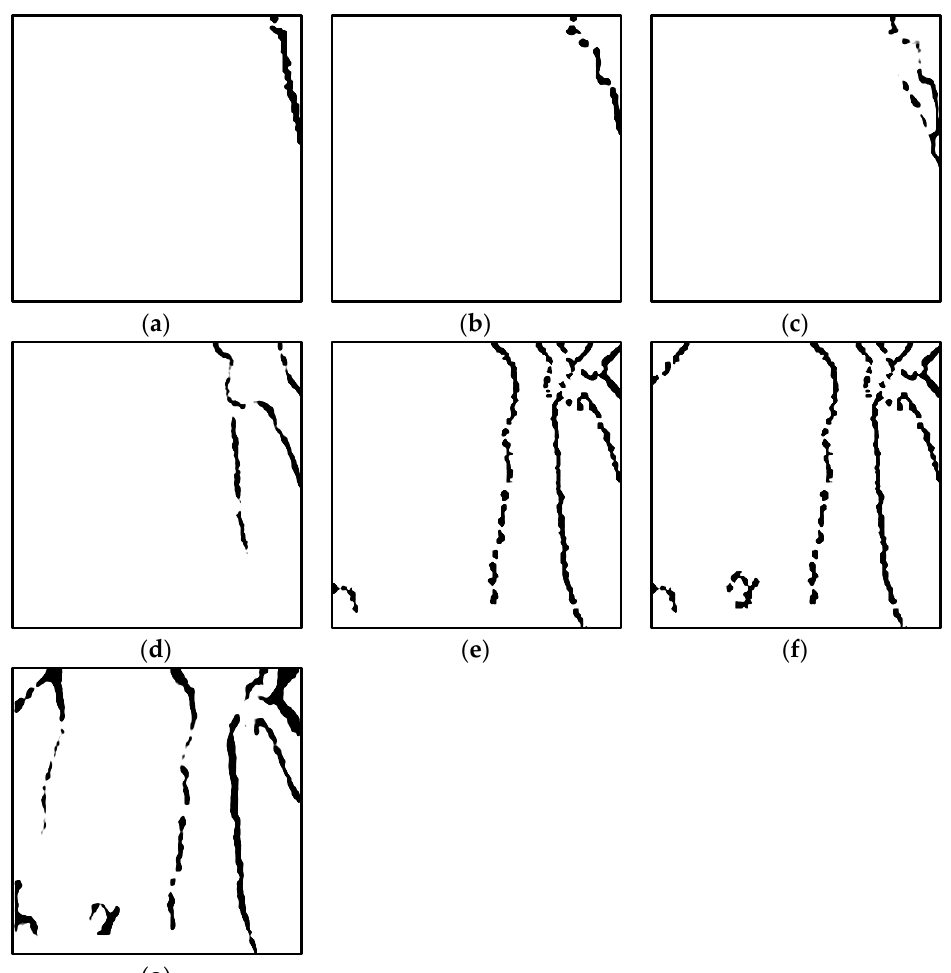
Figure 8. Stress–strain-dominant amplitude of the square shale sample (z-0-6).